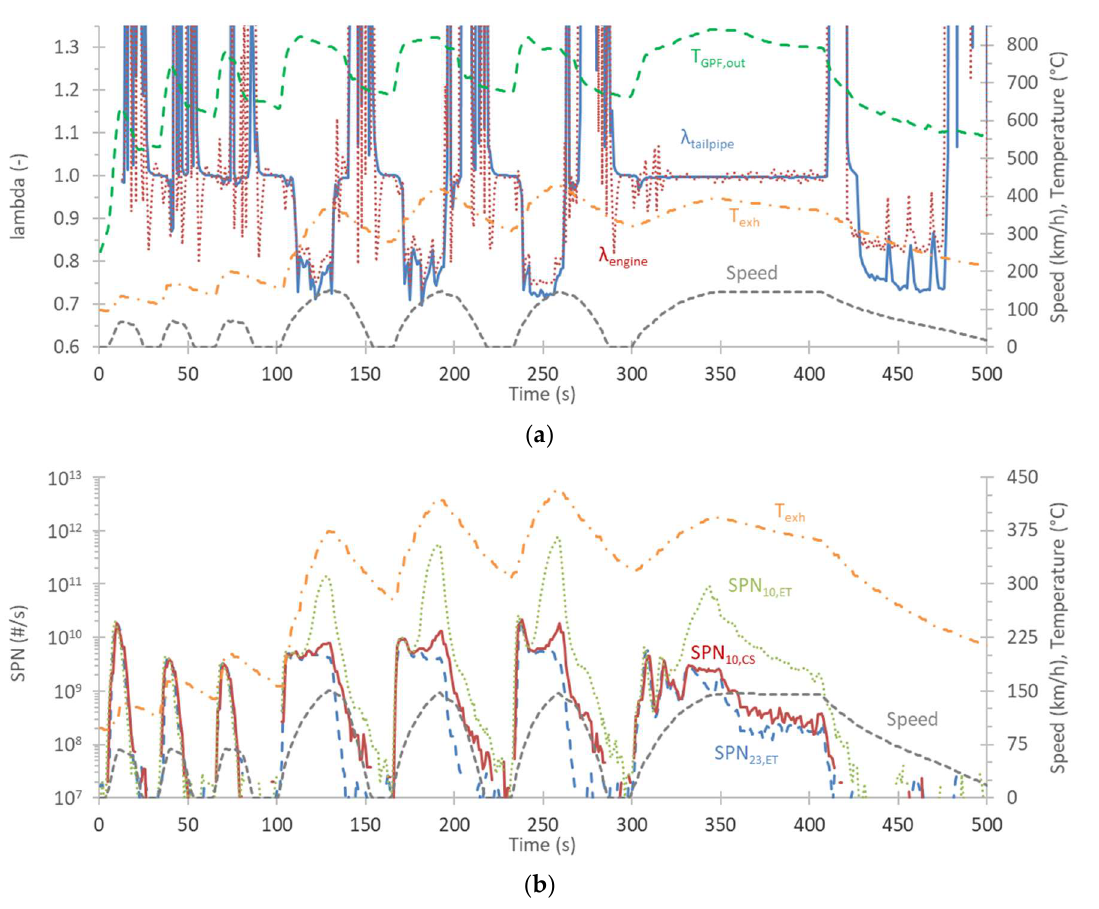
Figure 5. Acceleration tests at −4 °C: ( a ) lambda values at the engine out (engine) and downstream of the GPF (tailpipe). The speed profile and the exhaust gas temperature at the GPF (gasoline particulate filter) outlet and tailpipe (exh) are also given; ( b ) Solid particle number emissions >23 nm (SPN 23 ) and 10 nm (SPN 10 ), downstream of an evaporation tube (ET) or a catalytic stripper (CS). The speed profile and the exhaust gas temperature at the tailpipe outlet are also given.